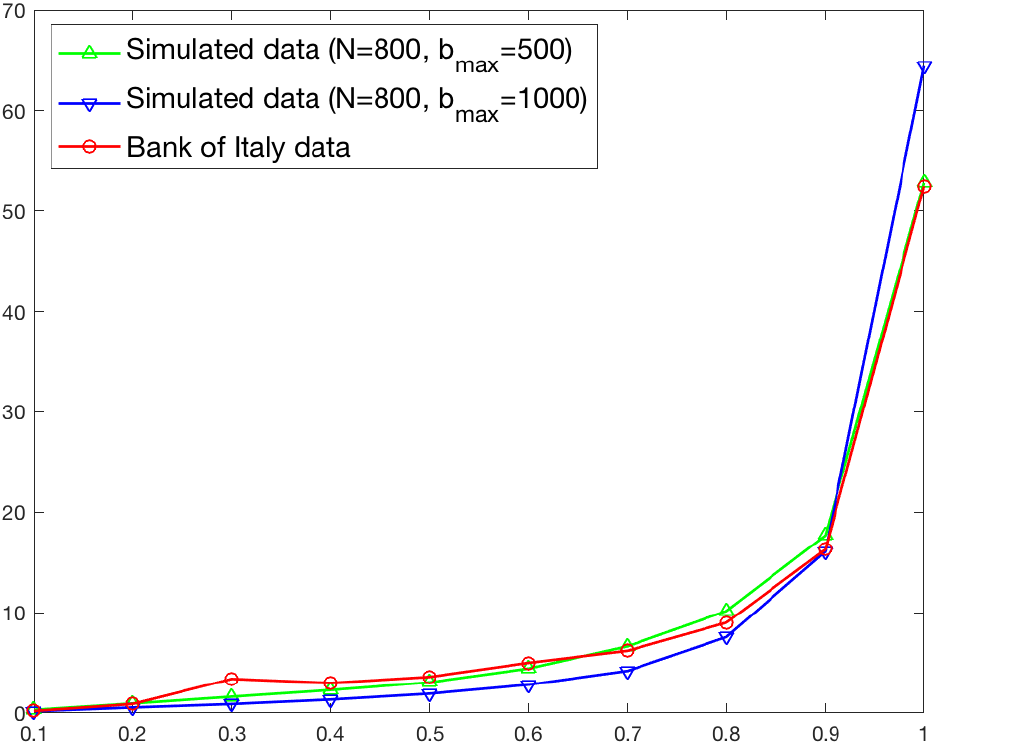
Figure 8. Comparison between the decile distribution of wealth in the simulation with b max = 500,1000, and the decile distribution of real Italian financial wealth in 2016 (source: Bank of